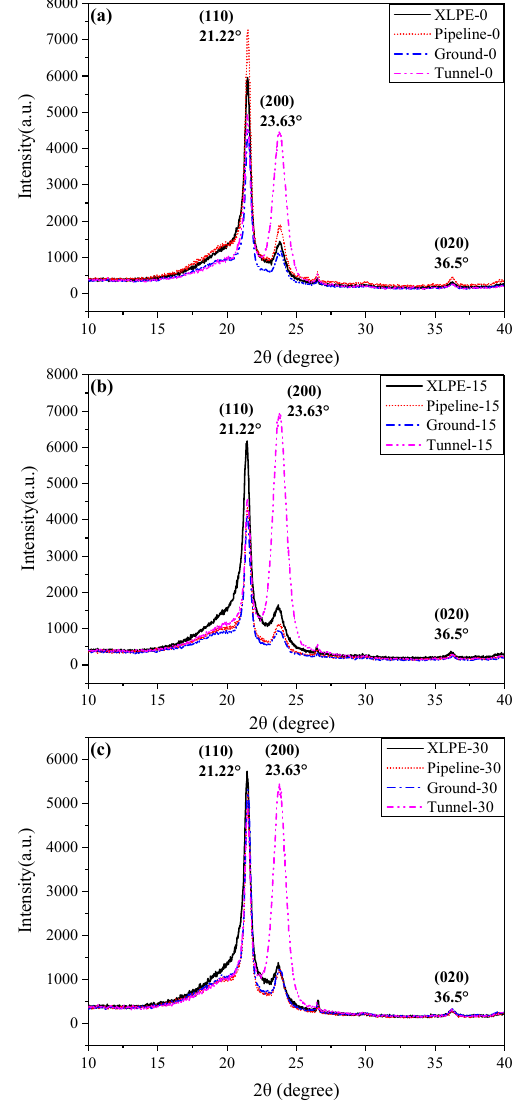
Figure 10. X-ray di ff raction (XRD) spectrum of the untreated specimens and the treated specimens Figure 10. X-ray diffraction (XRD) spectrum of the untreated specimens and the treated specimens under thermal aging of three di ff erent laying modes. ( a ) the spare cable; ( b ) the cable with service years under thermal aging of three different laying modes. (a) the spare cable; (b) the cable with service of 15; ( c ) the cable with service years of years of 15; (c) the cable with service years of 30.